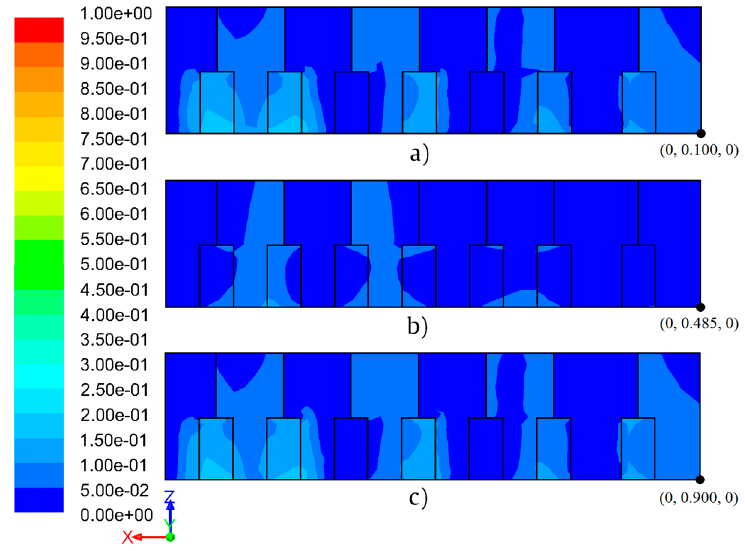
Figure 11. The results of the field of temperature in the x–z plane through the planes: ( a ) y adm = 0.100; ( b ) y adm = 0.485; and ( c ) y adm = 0.900.